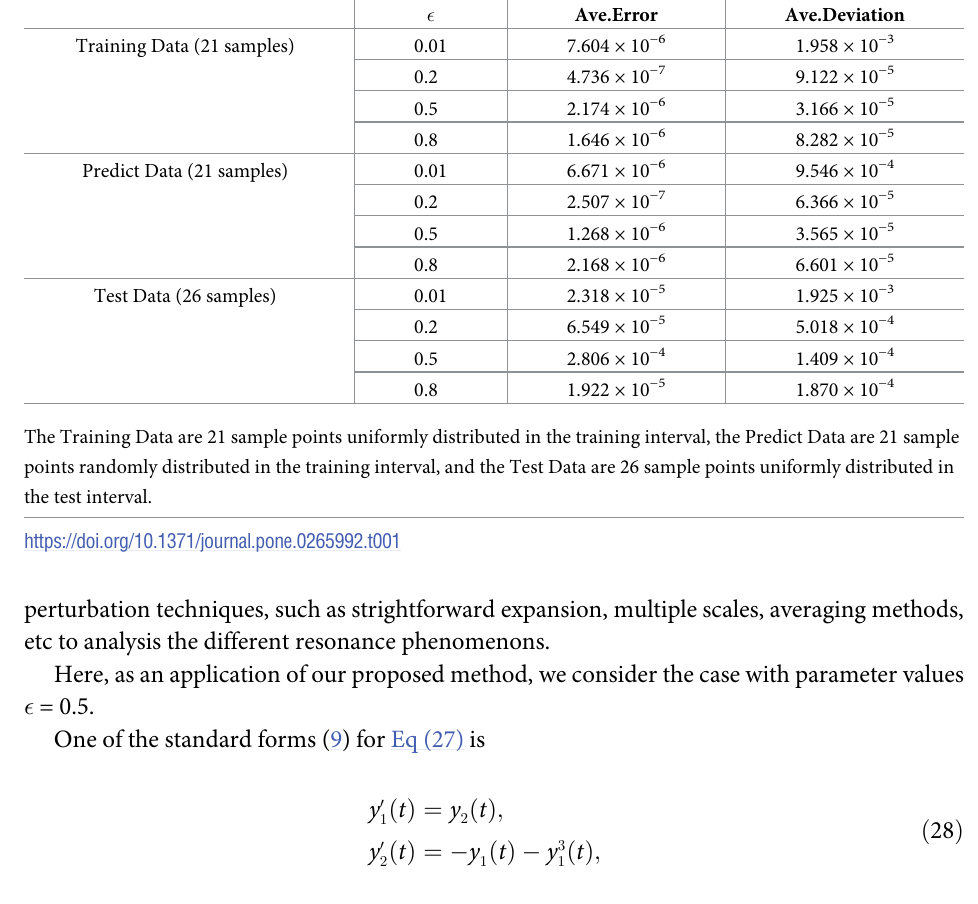
Table 1. Robustness of our method.